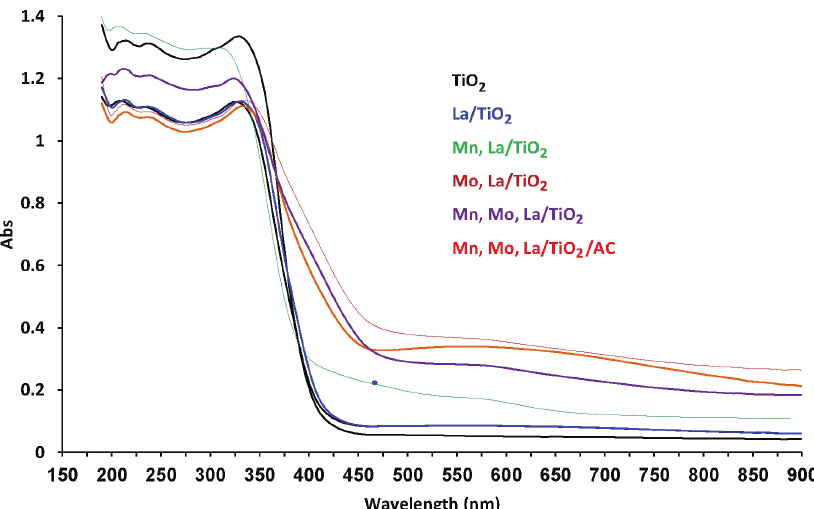
Fig. 3 – UV-vis diffusion reflectance spectra of pure TiO